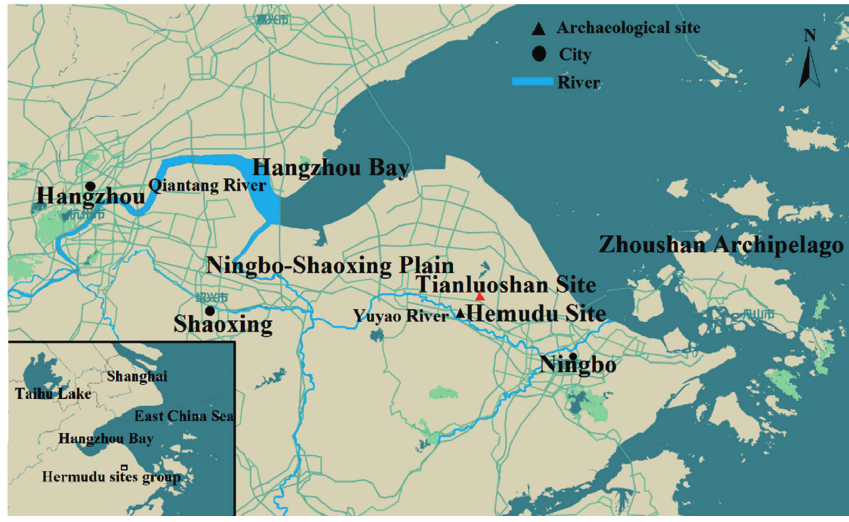
Figure 1: Location map of the Tianluoshan site.